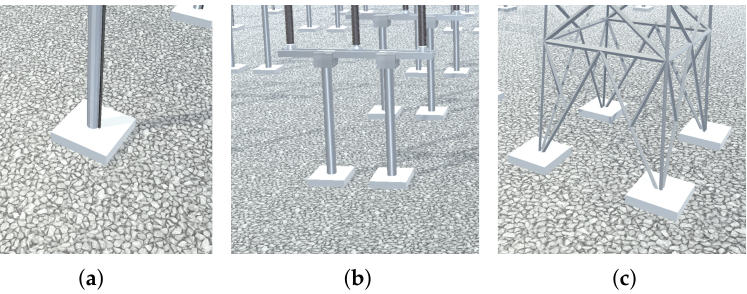
Figure 19. Application of the support bases to the ground: ( a ) single base; ( b ) double base supporting a disconnect switch; ( c ) quadruple base supporting a gantry tower.